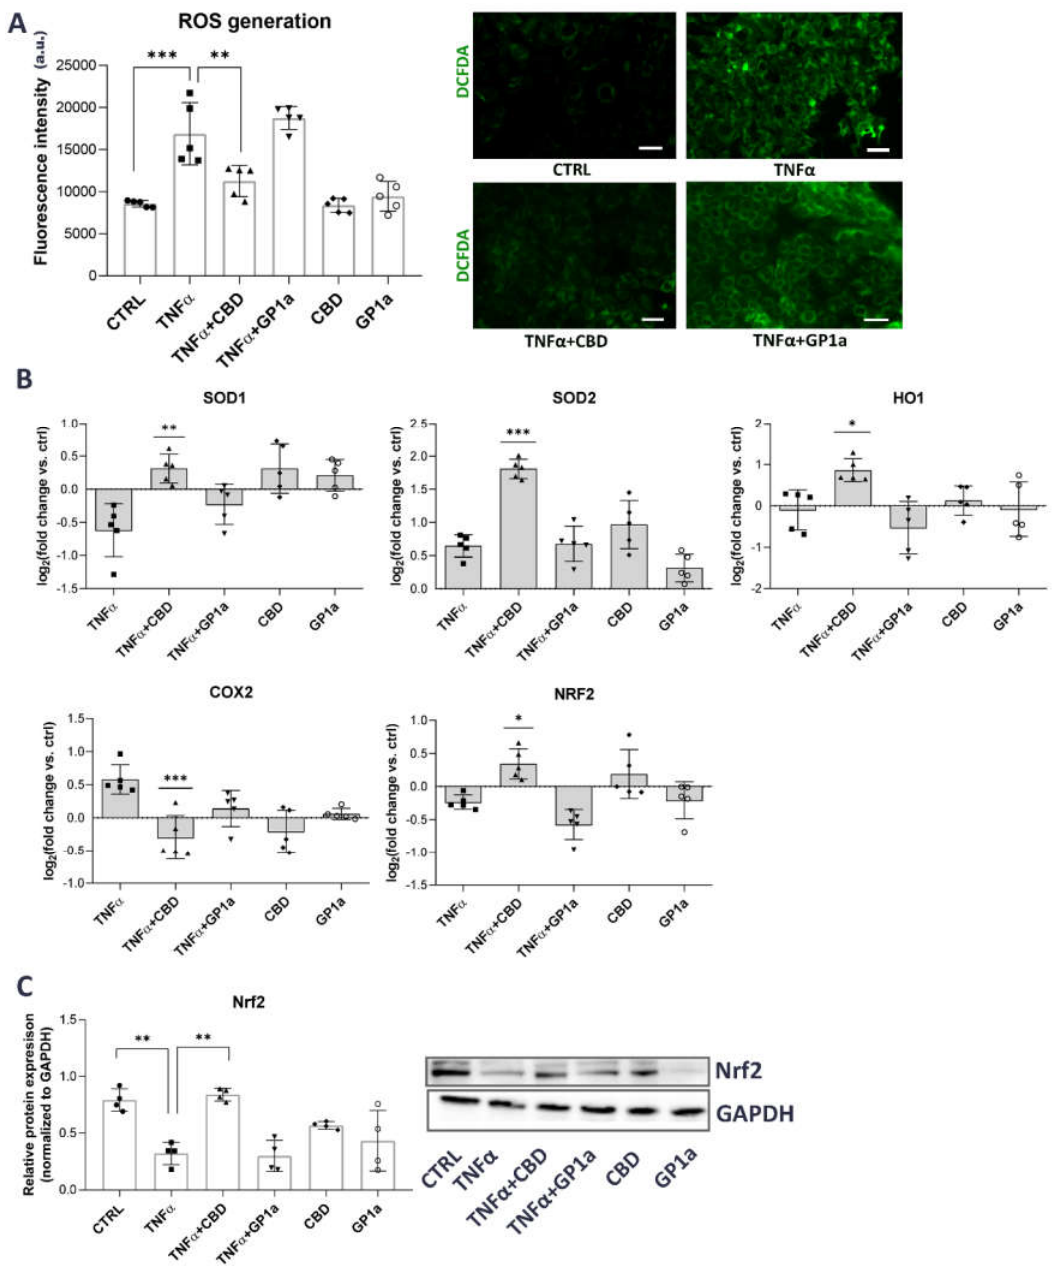
Figure 4. Antioxidant effects of CBD in TNF α -stimulated SV-HUC1 cells. ( A ) Cellular ROS generation in SV-HUC1 cells treated with TNF α (20 ng/mL) in the presence/absence of CBD (5 µ M) or GP1a (5 µ M) for 24 h and stained with DCFDA (green). Shown is mean ± SD fluorescence intensity determined in four independent experiments and representative images of three independent experiments performed. Images were taken at 10 × magnification. Scale bars: 50 µ m. a.u., arbitrary units, ** p < 0.01, *** p < 0.001. ( B ) mRNA expression of SOD1, SOD2, HO1, COX2 and Nrf2 in SV-HUC1 cells treated with TNF α (20 ng/mL) in the presence/absence of CBD (5 µ M) or GP1a (5 µ M) for 24 h determined by qPCR. Shown is mean ± SD log2 fold change vs. untreated control (set to 0) determined in five independent experiments. * p < 0.05, ** p < 0.01, *** p < 0.001 vs. TNF α -treated cells. ( C ) Protein levels of Nrf2 in SV-HUC1 cells treated with TNF α (20 ng/mL) in the presence/absence of CBD (5 µ M) or GP1a (5 µ M) for 24 h determined by western blot. Shown is mean ± SD relative protein expression normalized to the levels of GAPDH and representative blots of four independent experiments performed. ** p <